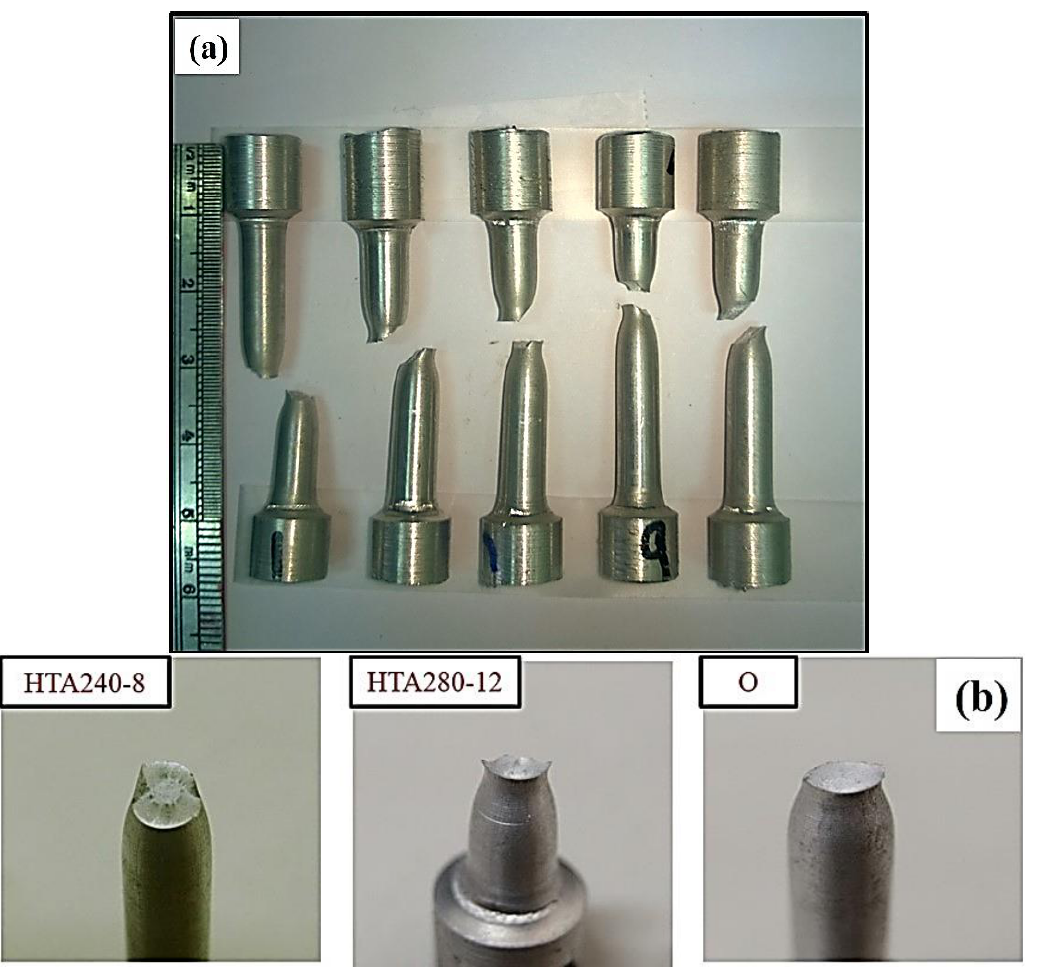
Figure 11. Macrostructures of tensile fracture of 7075 Al alloy extruded rod with various PPHTs: ( a ) specimens after tensile test; ( b ) the fracture surfaces.